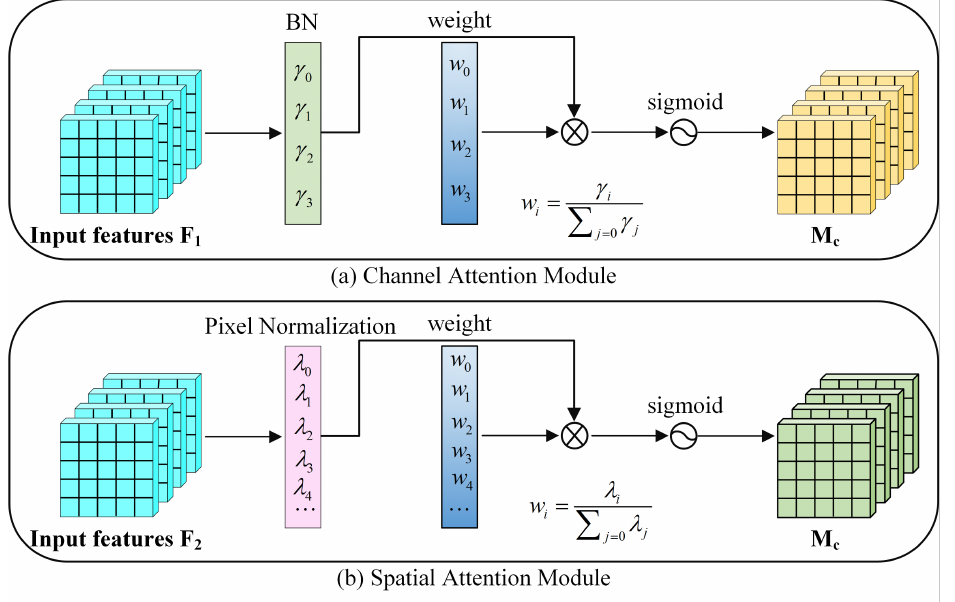
Figure 4. Architecture of the NAM Attention